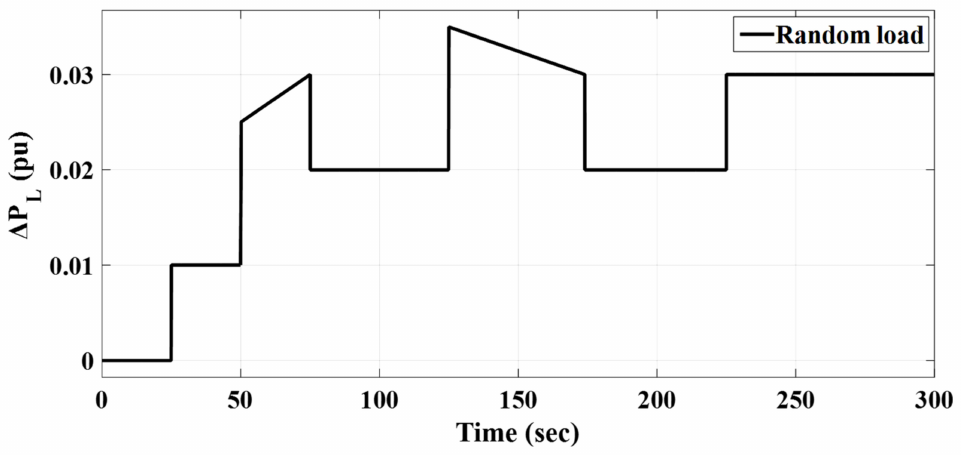
Figure 23. The form of the applied RLV.